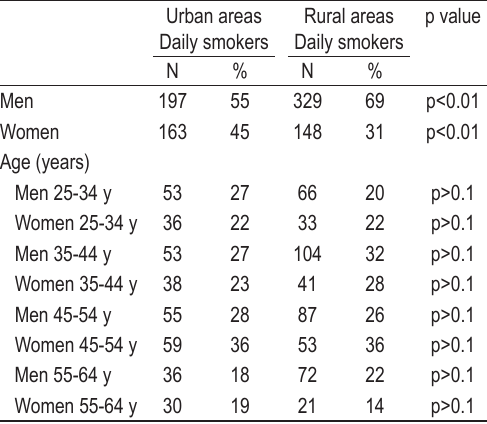
Table 1. Prevalence of smoking according to age and sex, urban/rural